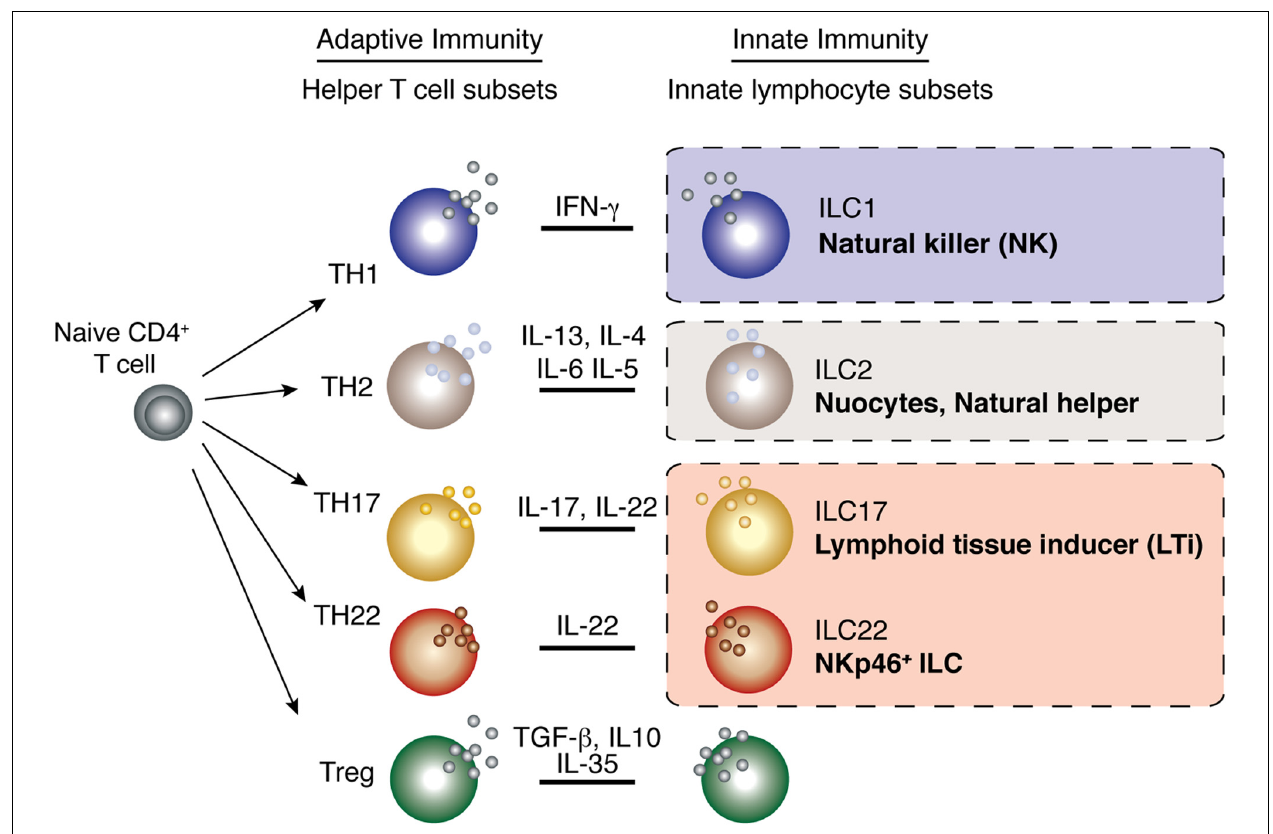
FIGURE 1 | Parallels between innate lymphocyte populations and CD4 + helperT cell subsets. Multiple populations of CD4 + helperT cells exist and these are characterized by the production of signature cytokines by each